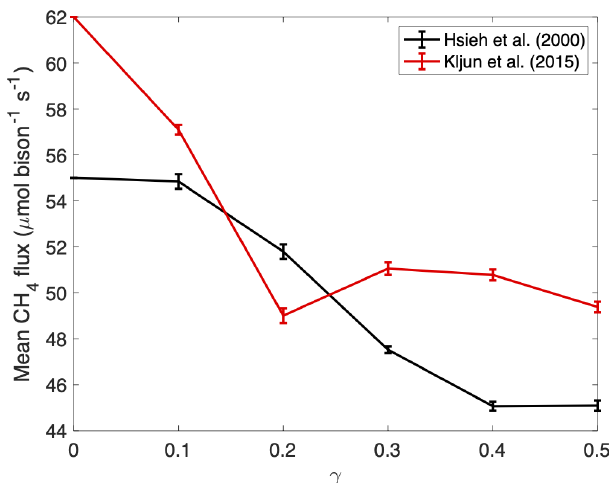
Figure 12. The estimated mean per-bison CH 4 efflux from stochas- tic simulations of bison locations using a probability surface defined by two-dimensional Tikhonov regularization (see Supplement) for different values of the Lagrange multiplier γ . Error bars represent standard error about the mean of 20